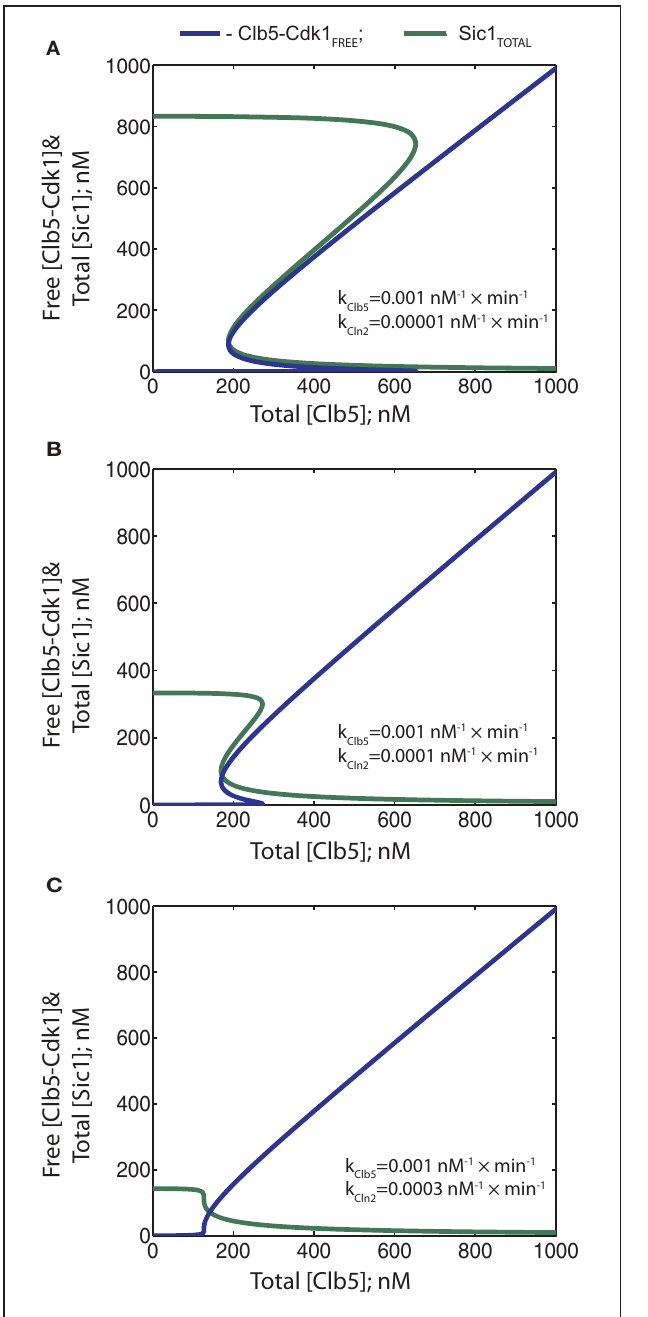
FIGURE 6 | (A–C) Phase diagrams showing the effect of changes in the relative ability of Cln2-Cdk1 to directly cause the degradation of Sic1. The rate constant values for Cln2-Cdk1 were gradually increased as indicated.